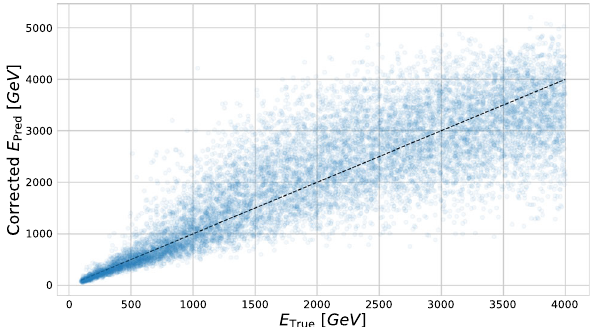
Fig. 10 Corrected predictions on validation data resulting from the inversion of the fit as a function of the true energy. The black dashed line indicates the ideal